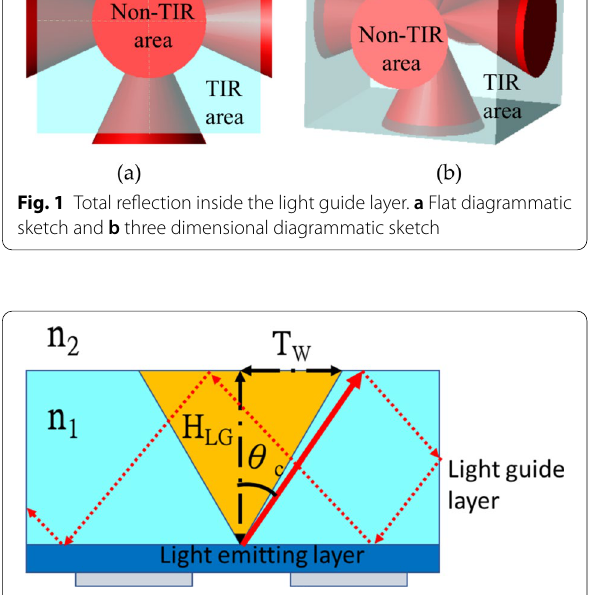
Fig. 2 Schematic of the UV‑C LED TIR phenomenon